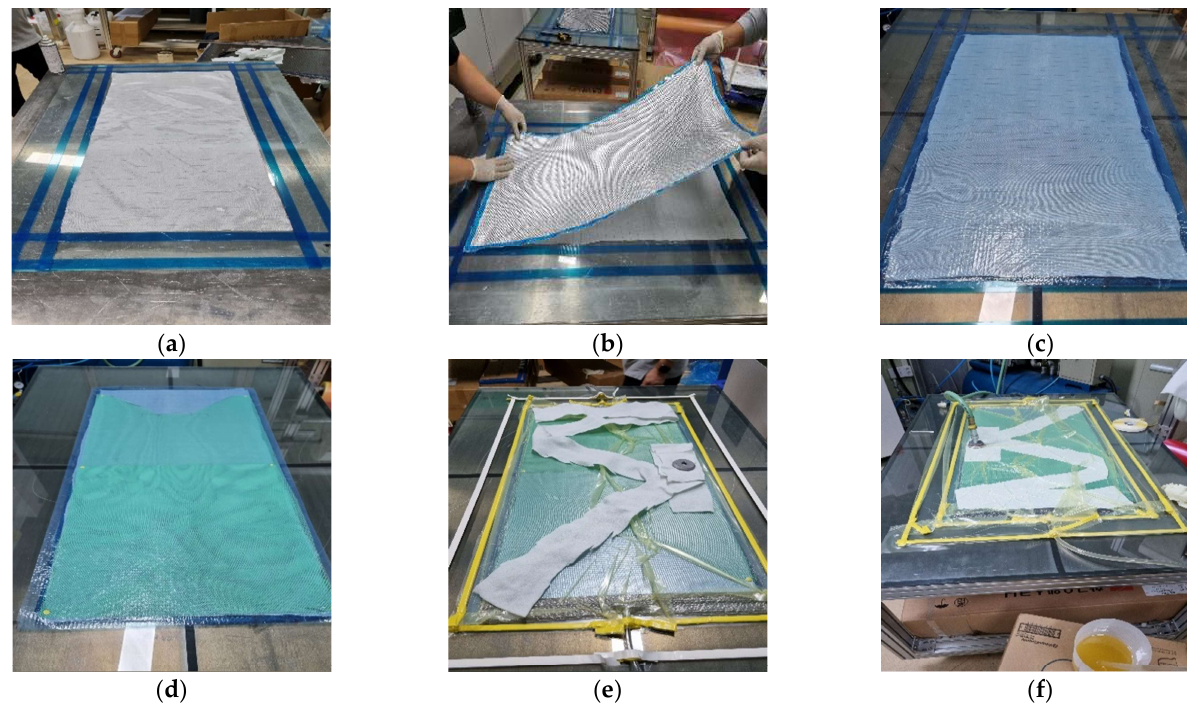
Figure 5. Specimen fabrication by resin infusion method. ( a ) Peel ply lamination. ( b ) Fabric lamination. ( c ) Release film lamination. ( d ) Mesh lamination. ( e ) Installation of omega flow and resin port. ( f ) Resin injection after vacuum bagging.